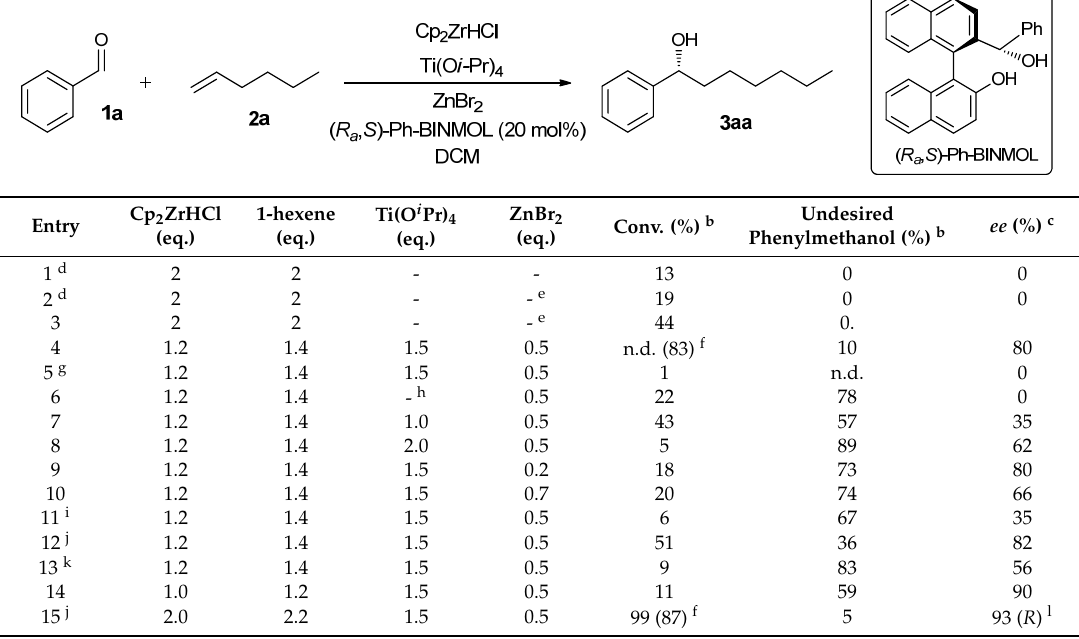
Molecules 2018 , 23 , x FOR PEER REVIEW Table 1. Optimisation of reaction conditions for the addition of 1 ‐ hexene ( 2a ) to benzaldehyde ( 1a ) a Table 1. Optimisation of reaction conditions for the addition of 1-hexene ( 2a ) to benzaldehyde ( 1a ) a .